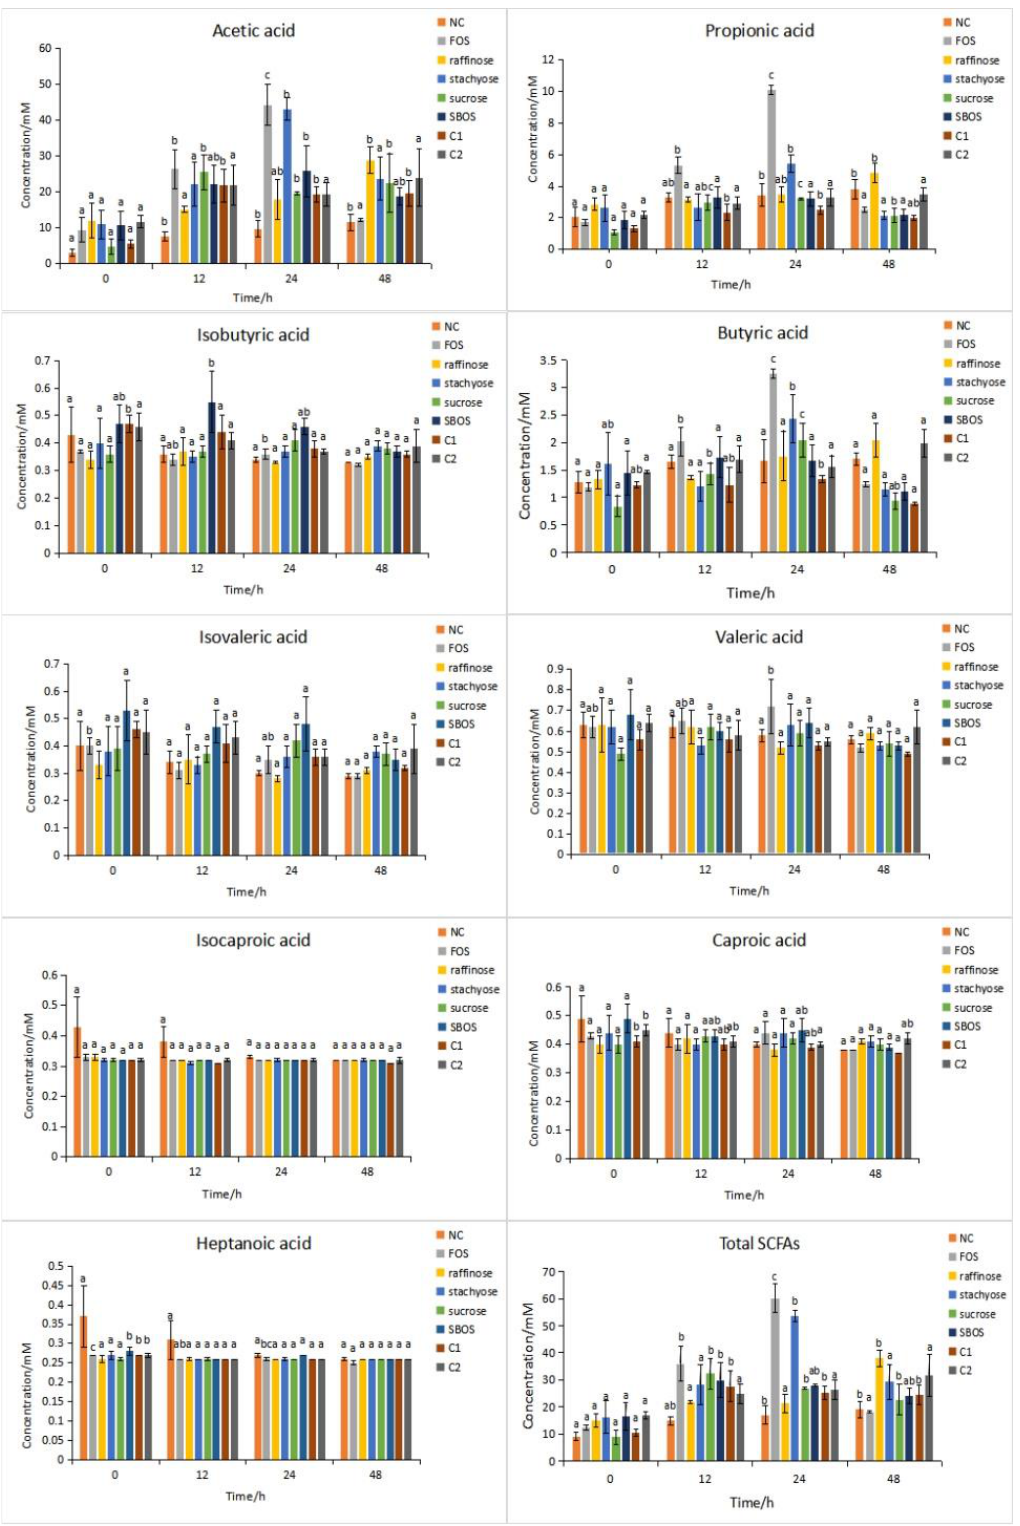
Figure 3. Concentrations (mM) of SCFAs during in vitro fermentation at different time points. One- way ANOVA and Duncan’s test were used to evaluate significant differences for SCFAs production. Different lowercase letters with different times were significantly different ( p < 0.05).